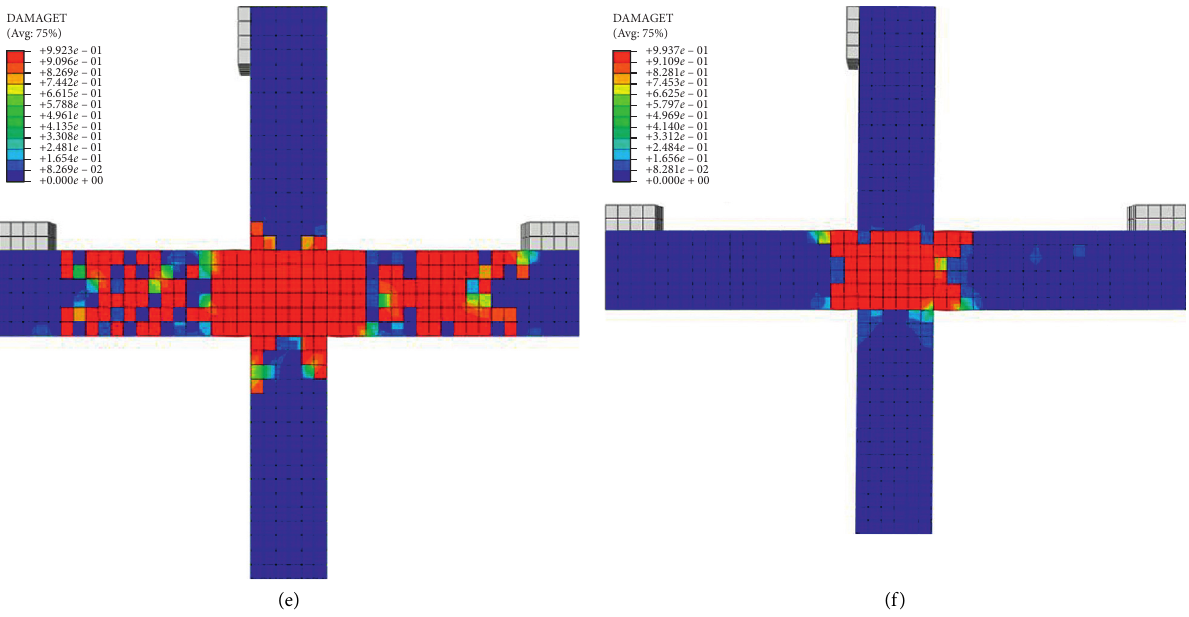
Figure 9: The crackle developing prefabricated reinforced concrete beam-column joints with grouted sleeves by finite element simulation. (a) Tensile damage in the beam-column interface. (b) The cracks gradually spread into beam 1. (c) The cracks gradually spread into beam 2. (d) The cracks gradually spread into beam 3. (e) Tensile cracks distribution at peak displacement loading. (f) Compressive crack distribution at peak displacement loading.